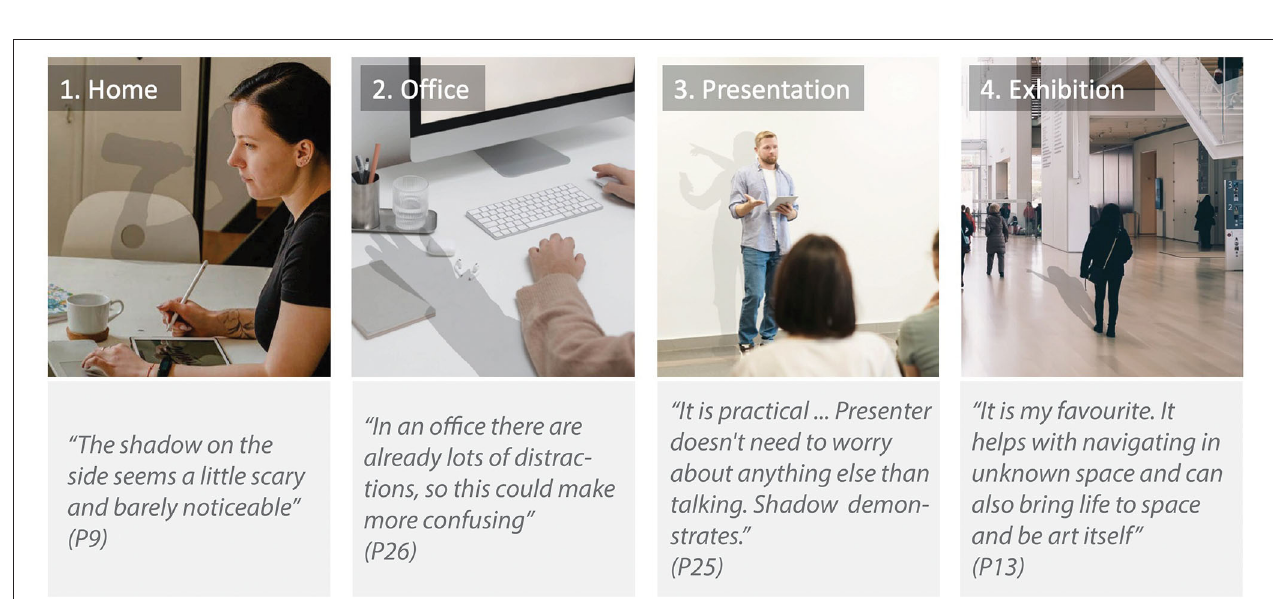
FIGURE 6 | Examples of the authors’ works creating a digital aura. L-R: clothing integrated AR markers, AR jewelry.